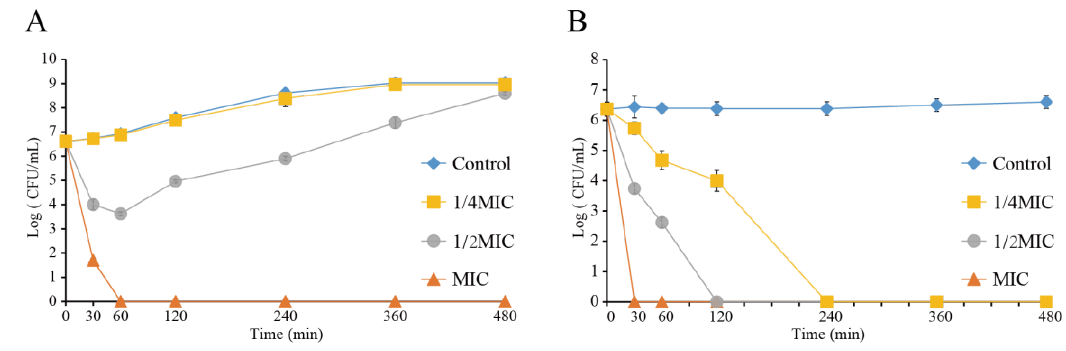
Figure 7. Effect of LC-EO on C. sakazakii populations in TSB ( A ) and PBS ( B ).